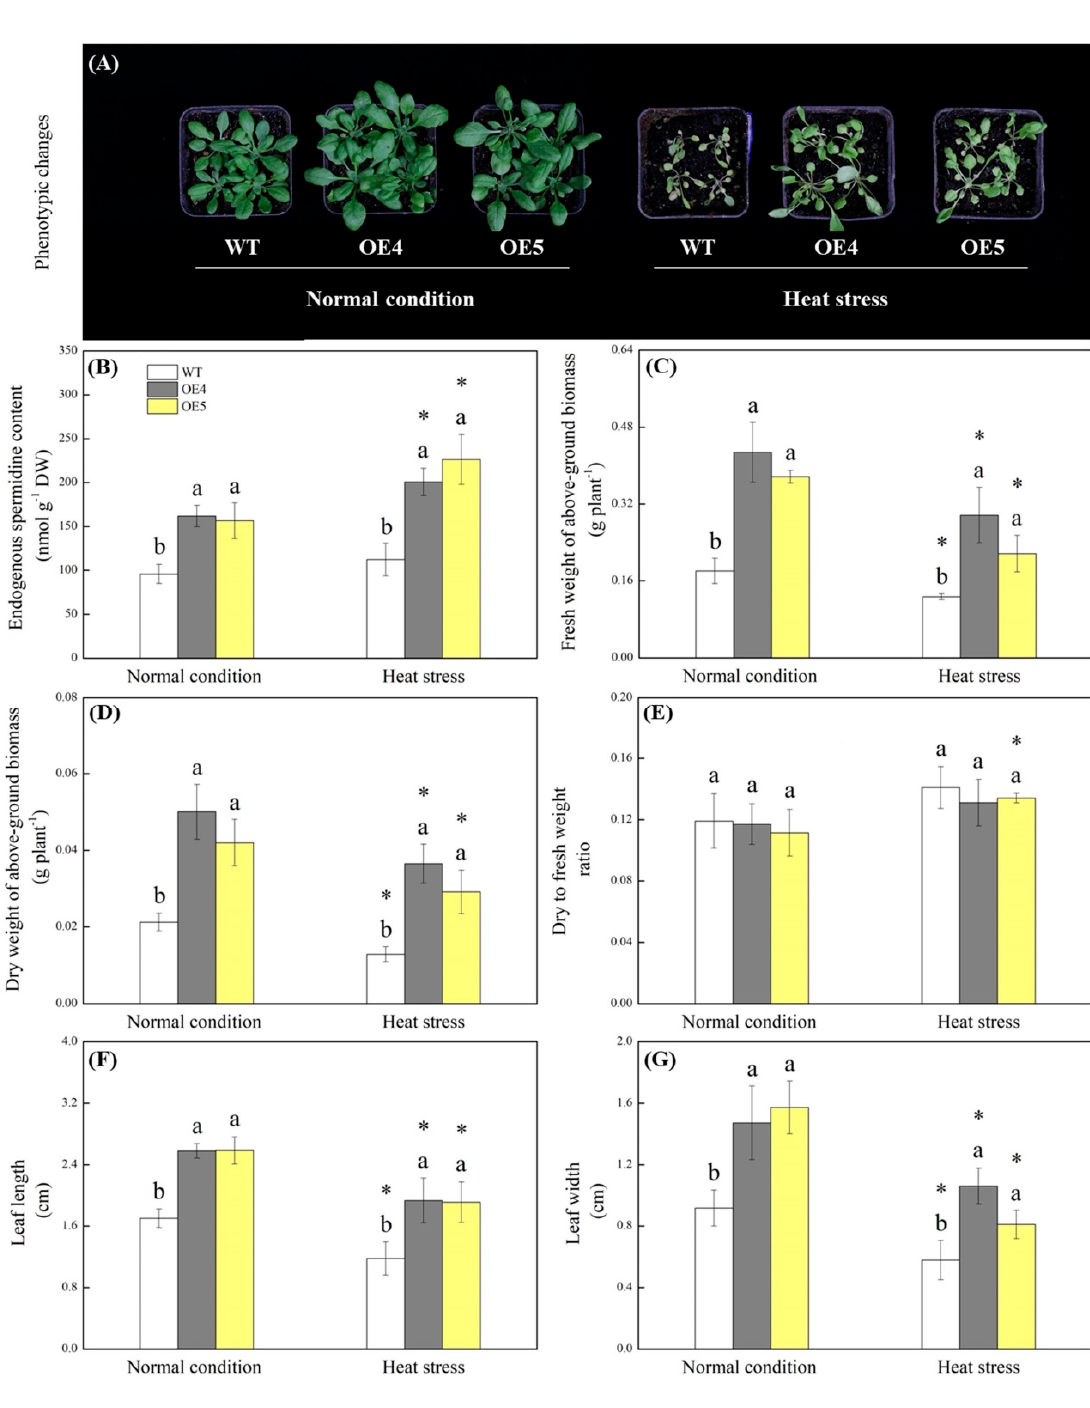
Figure 3. Changes in ( A ) phenotype, ( B ) endogenous spermidine content, ( C ) fresh weight of above-ground biomass, ( D ) dry weight of above-ground biomass, ( E ) dry to fresh weight ratio, ( F ) leaf length, and ( G ) leaf width of wild type (WT) and transgenic Arabidopsis thaliana overexpressing the TrSAMS (OE4 and OE5) involved in spermidine biosynthesis under normal condition and heat stress. Vertical bars indicate ±SE of mean ( n = 4). Different letters above column indicate significant differences ( p ≤ 0.05) among treatments under a particular condition (normal condition or heat stress). The asterisk “*” indicates significant differences ( p ≤ 0.05) for a particular material (WT, OE4, or OE5) for comparison between normal condition and heat stress.